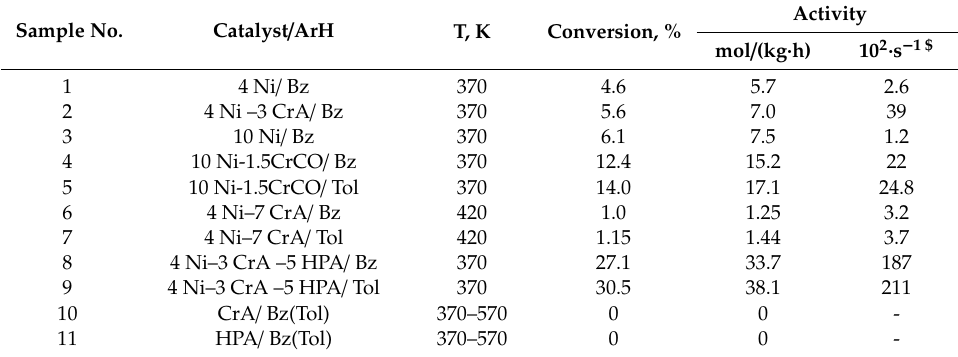
Table 2. Benzene and toluene hydrogenation over alumina supported Ni-containing catalysts; weight hourly space velocity (WHSV) 5 h − 1 , pressure 0.1 MPa (H 2 / ArH = 10). Sample